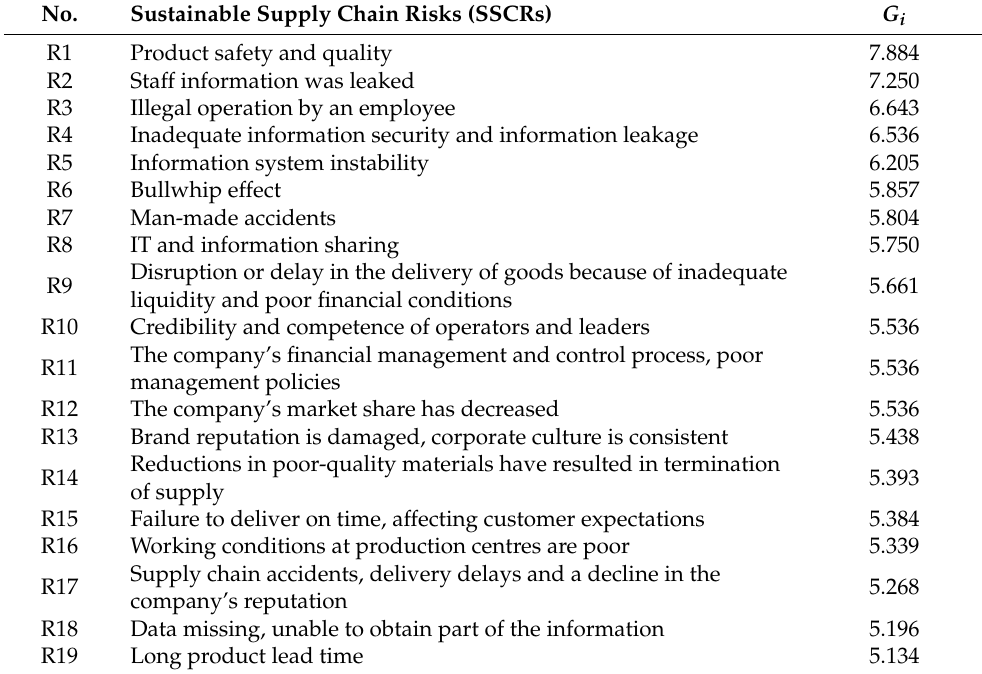
Table 3. Key SSCRs after screening.